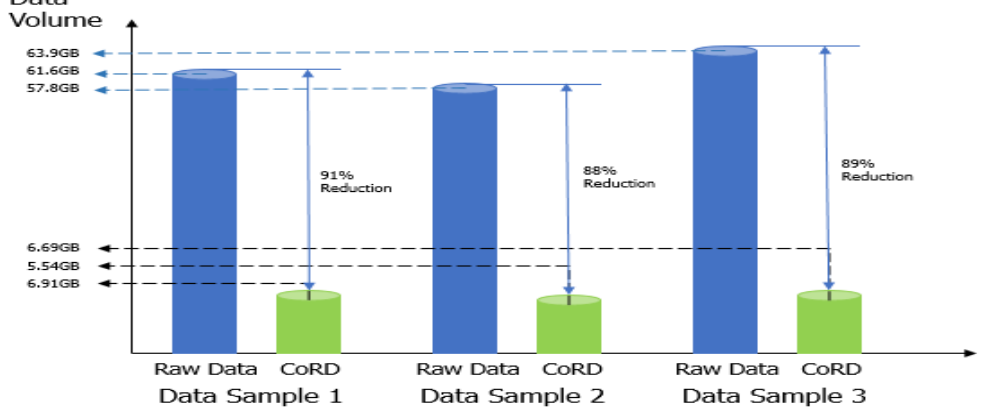
Figure 5. Data reduction